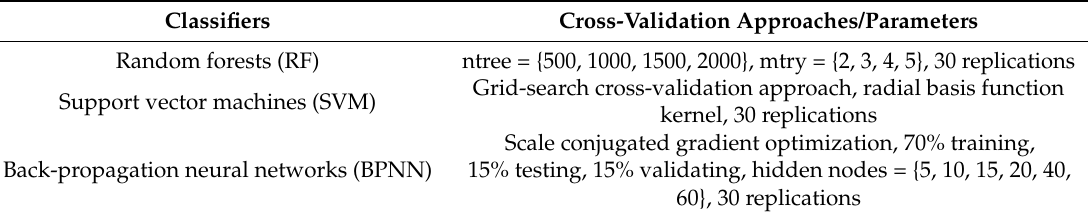
Table 2. Parameter tuning of all